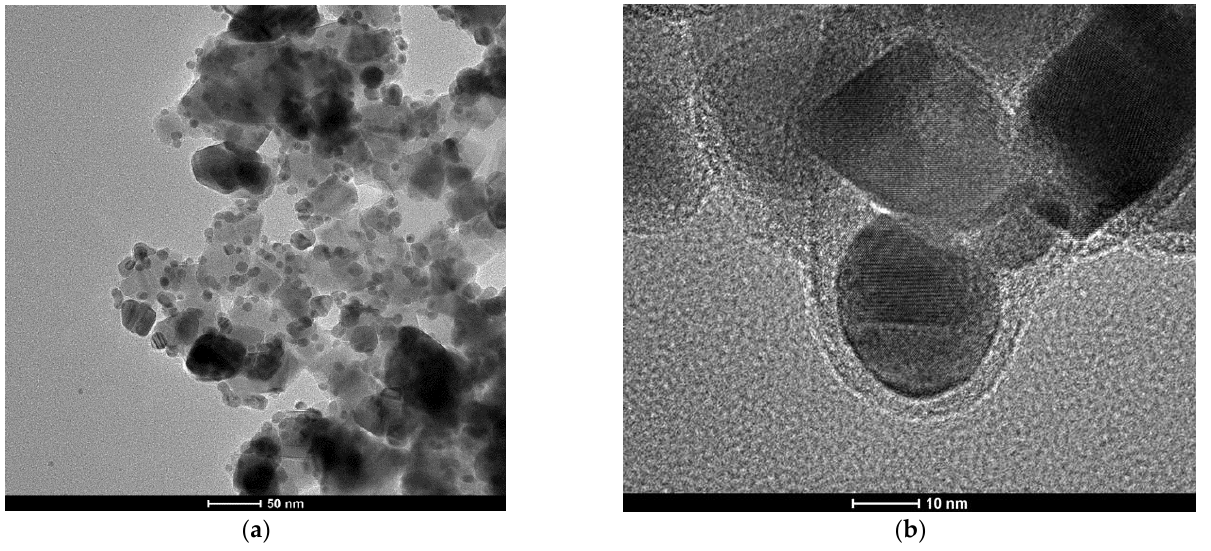
Figure 2. Example TEM images of the resulting (Fe 3 O 4 @Ag)@SiO 2 nanocomposite. ( a ) 50 nm scale; ( b ) 10 nm scale. The accelerating voltage of the TEM microscope: 200 kV. The nanoparticles were deposited using a simple wet deposition method onto a 400-mesh copper grid covered with a carbon film.